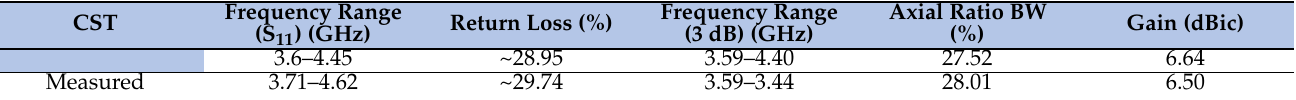
Table 3. Analysis of measured and simulated results.